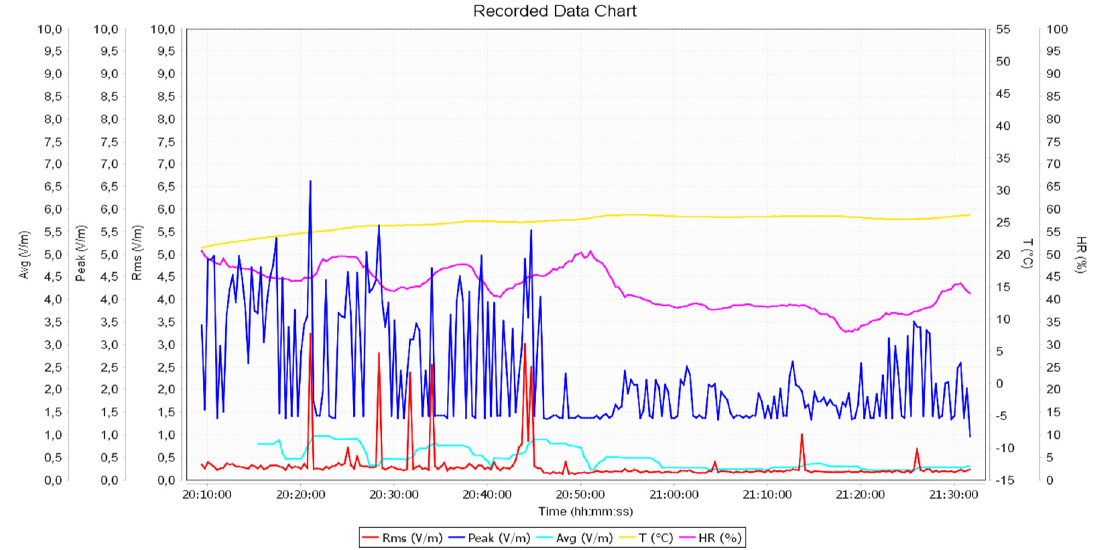
Figure 12. The intensity of the electrical component of the electromagnetic field in the course of flight no. 1 for the Robinson R44.